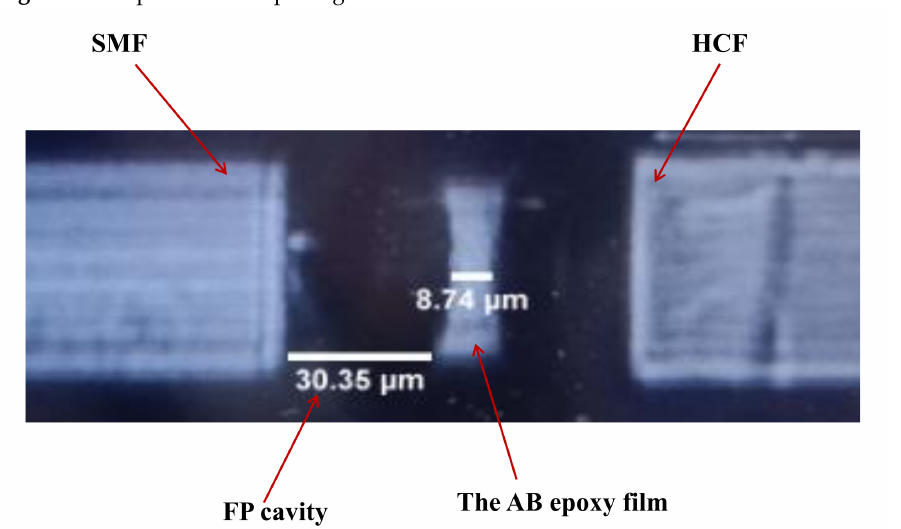
Figure 6. The picture of cavity length and film thickness